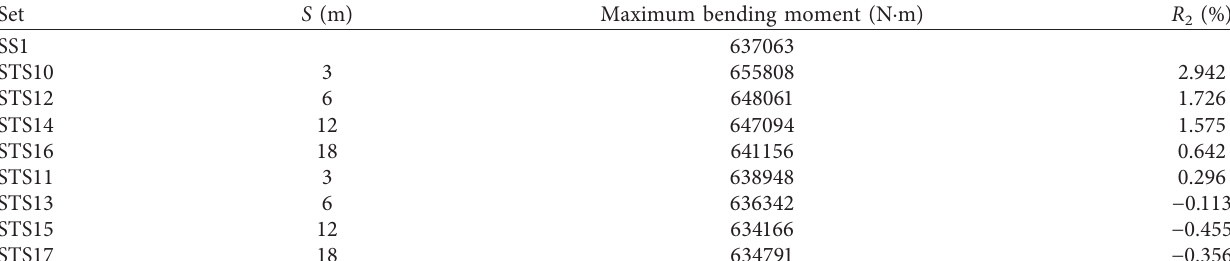
Table 7: Maximum bending moment at the corner of the station.